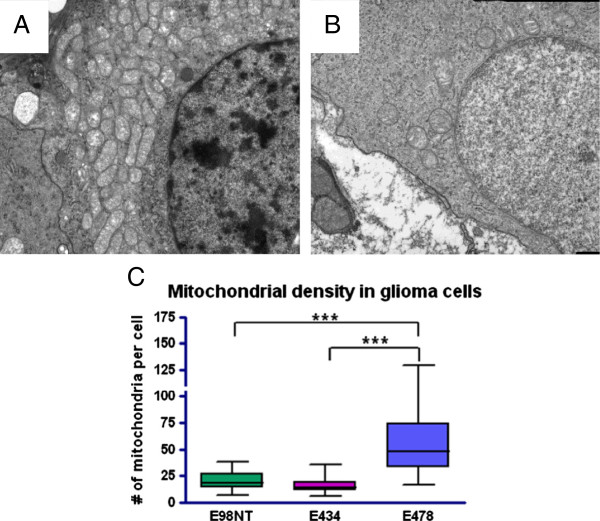
Transmission electron microscopy. Transmission electron microscopical micrographs of the increased mitochondrial density in E478 (A) as compared to E434 xenografts (B). C) Quantification of mitochondrial densities in IDHwt E98 and E434 xenografts and IDH1-R132H E478 xenografts).